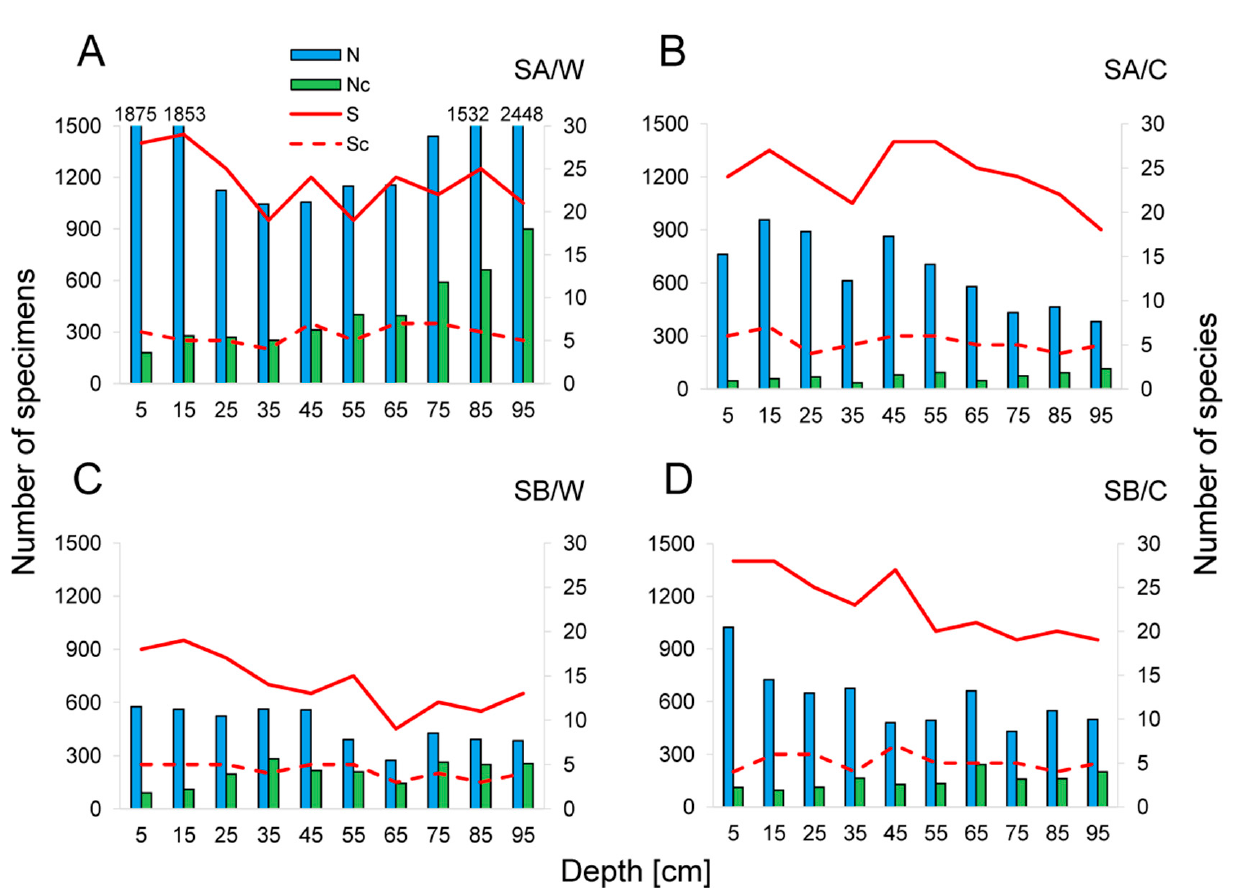
Figure 3. ( A – D ) Vertical distribution of Collembola and separately cold-adapted species along the depth profile (5–95 cm) at two scree sites (SA, SB) in two periods; W—warm period, C—cold period, N—total number of Collembola specimens, Nc—number of specimens of cold-adapted species, S—total number of Collembola species, Sc—number of cold-adapted species.